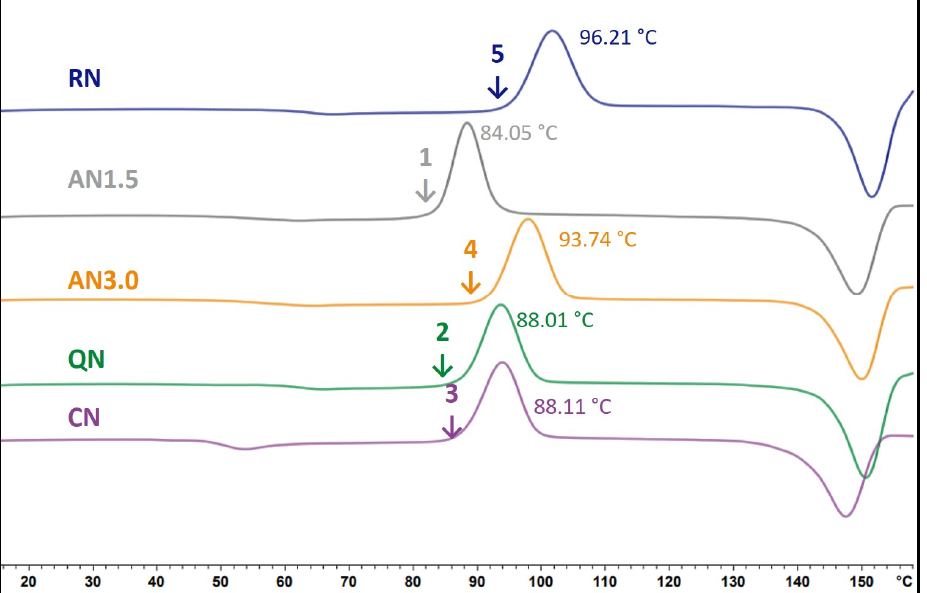
Figure 10. DSC thermograms of the 2 mg/mLg_1.6PS_Suc formulations. Processes as indicated at the corresponding curve. The temperature in °C displays the onset of crystallization temperature. The numbers rank the order of crystallization onset, starting with the first sample that starts to crys- tallize.